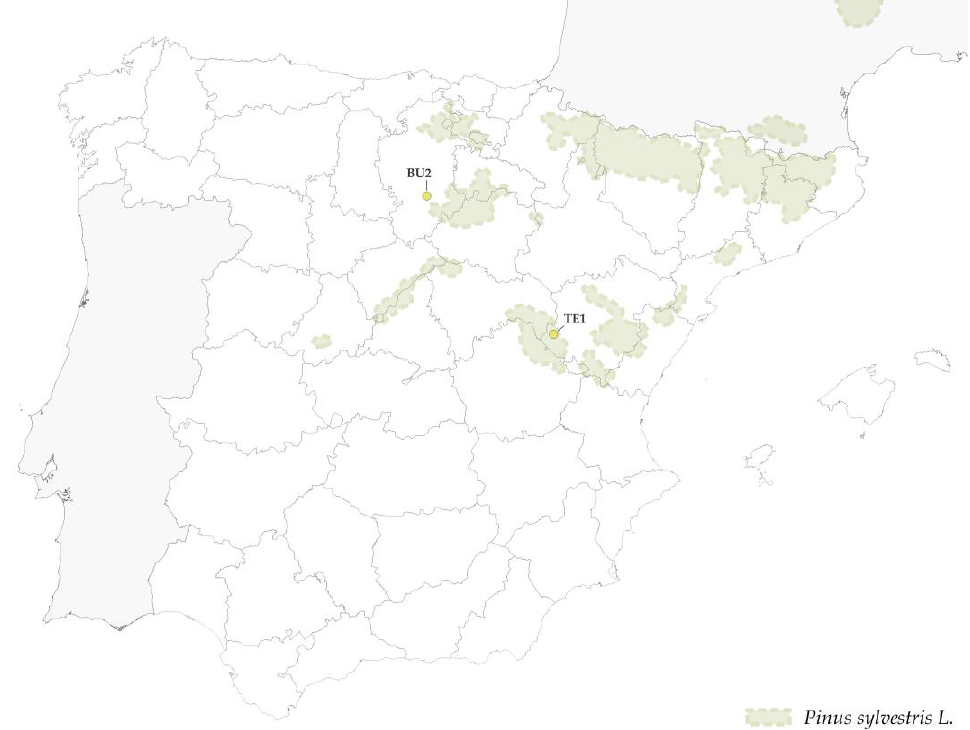
Figure 19. Distribution map for the species Pinys sylvestris L. and location of the case studies identified as belonging to this species. Map drawn up by the authors using information obtained from the database Chorological Data for the Main European Woody Species